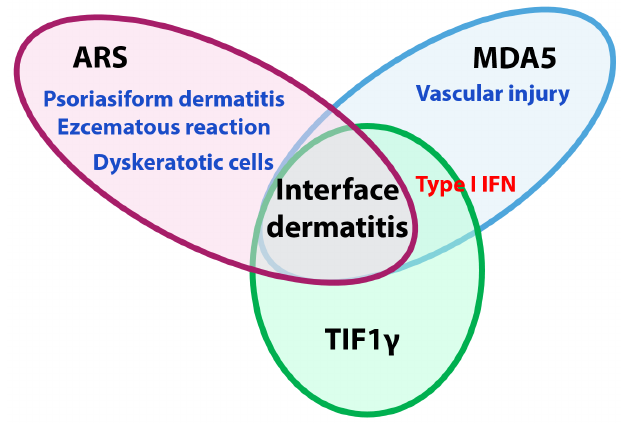
Figure 1. Histopathological classification of skin eruptions in myositis-specific autoantibody-associated groups. The anti-aminoacyl-transfer RNA synthetase (ARS) antibody-positive dermatomyositis (DM) group is characterized by a mixture of psoriasiform dermatitis and eczematous reaction with interface dermatitis mainly presenting dyskeratotic cells and without epidermal expression of myxovirus resistance A (MxA). Vascular injury in the upper dermis and high epidermal expression of MxA are observed in patients with anti-melanoma differentiation-associated protein 5 (anti-MDA5) antibody-positive DM. Epidermal expression of MxA is also detected in patients with anti-transcriptional intermediary factor 1 γ (TIF1 γ ) antibody-positive DM. IFN,